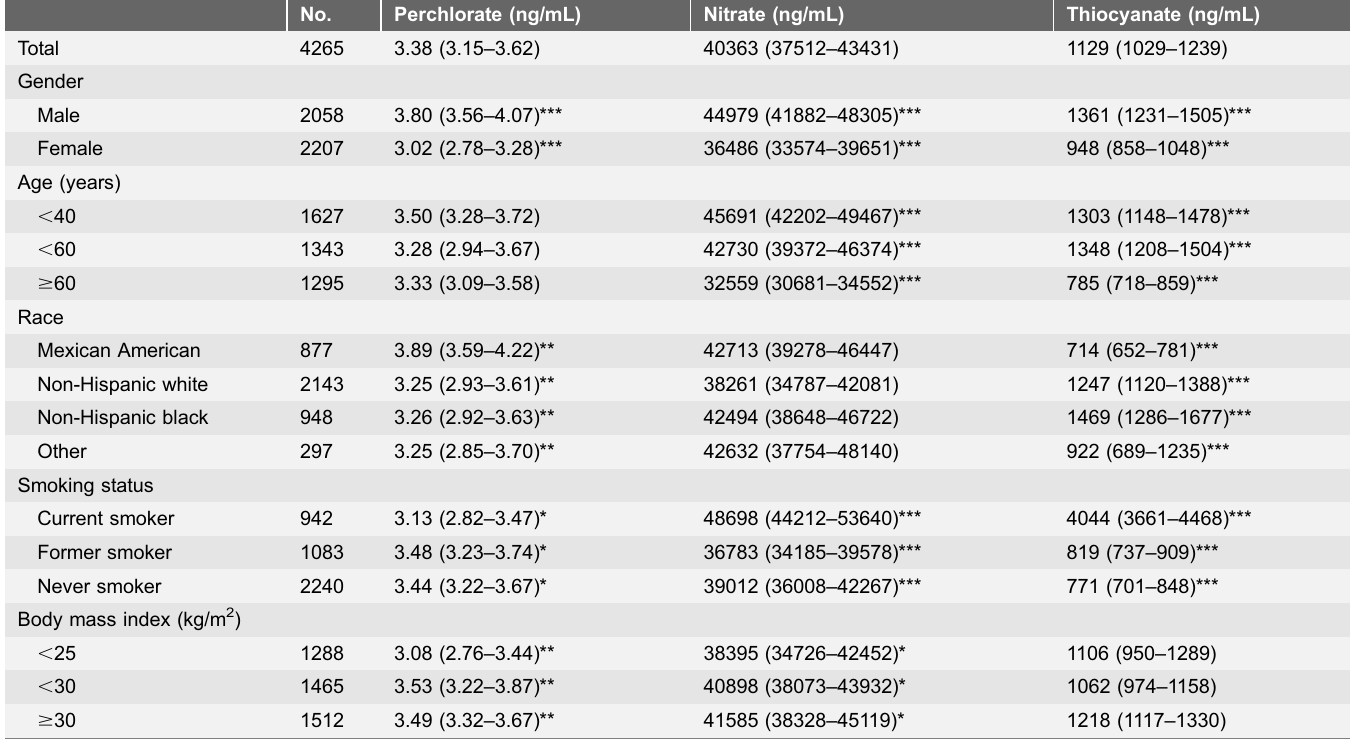
Table 1. Demographics and geometric means with 95% confidence intervals of urinary concentrations of perchlorate, nitrate, and thiocyanate among the United States adults, NHANES 2005–2006.